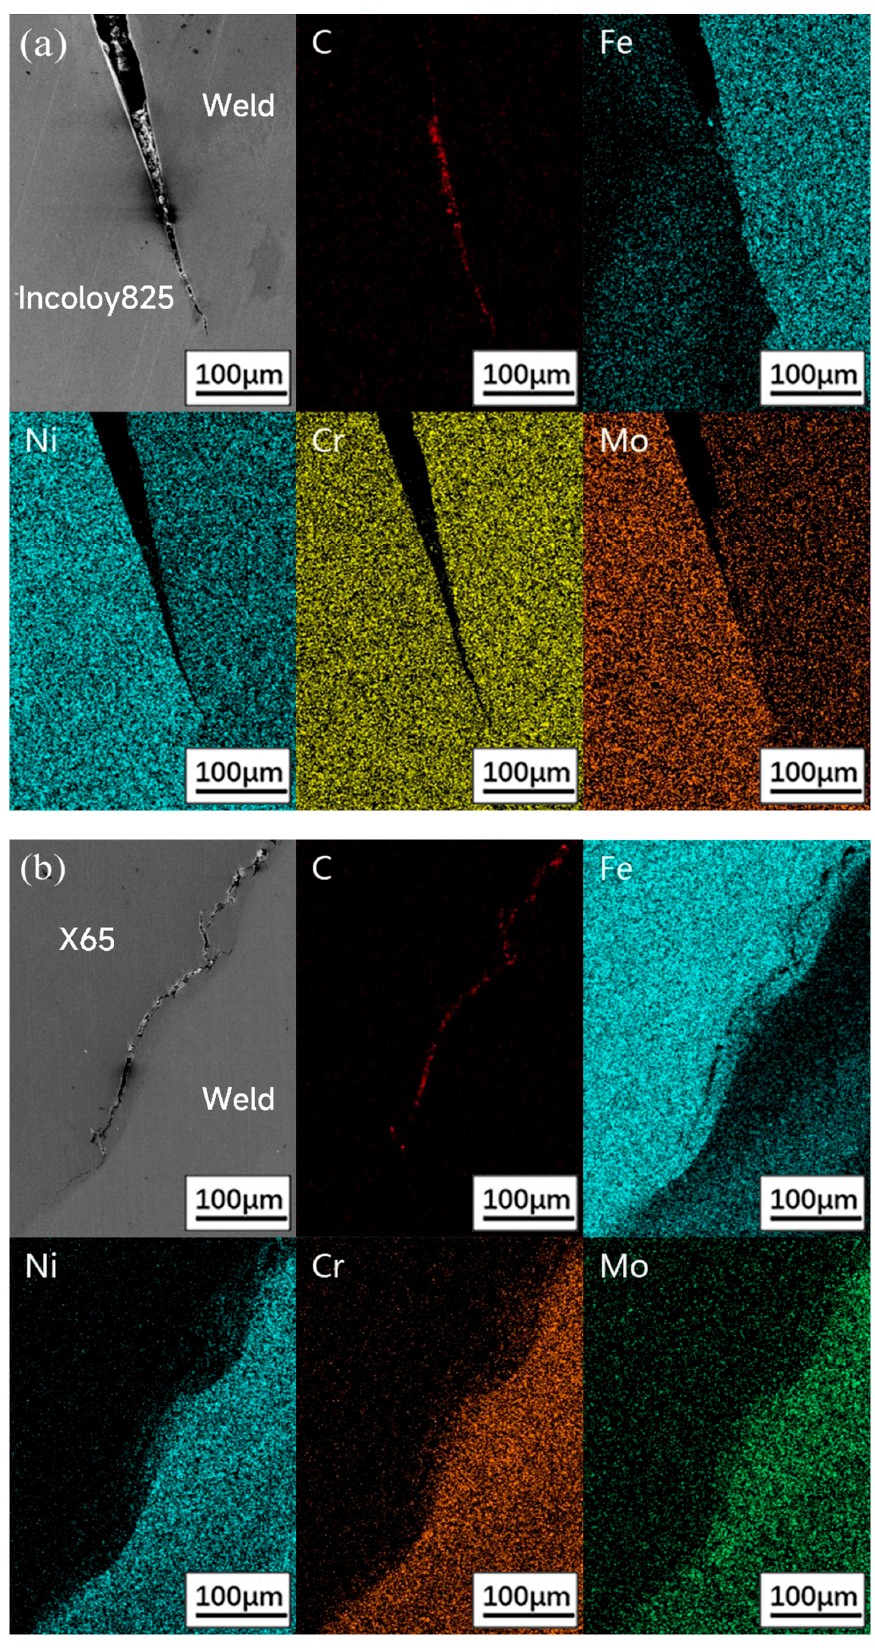
Figure 9. The element surface scanning at tips of crack 1 and crack 2: ( a ) crack 1; ( b ) crack